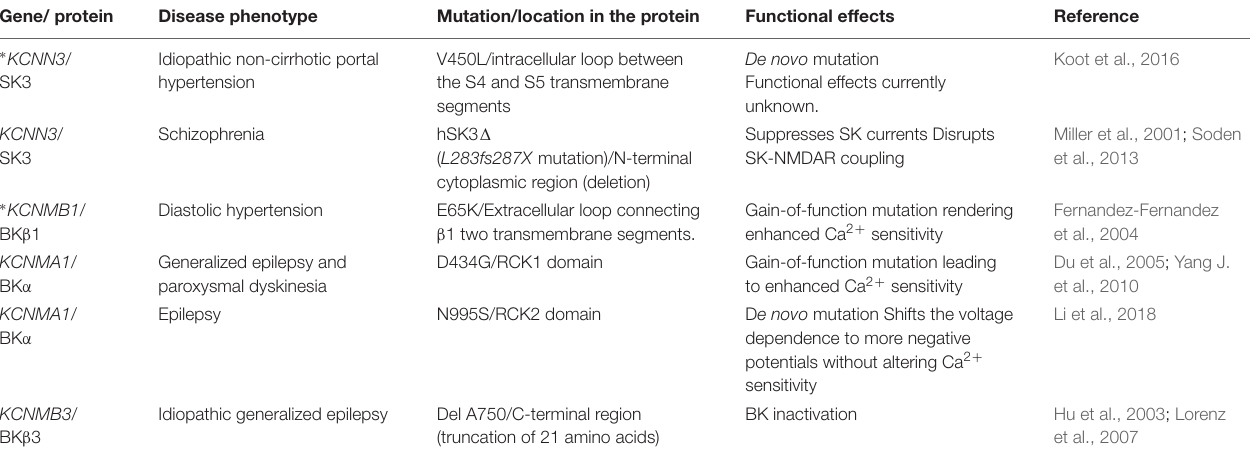
TABLE 1 | Mutations in K Ca channels that are associated in human diseases, their location in the channel protein, functional implications and related